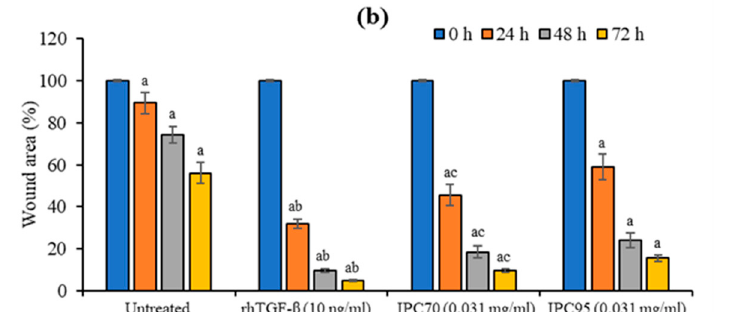
Figure 4. In vitro wound healing of CCD-986sk cells treated with IPC70 and IPC95 extracts. ( a ) Scratch wounds were observed using an inverted light microscopic (magnification × 100). ( b ) The percentage of cell-free or wound area was measured using the Image J program. The data are means ± SD from three independent experiments. The superscript letters ( a,b,c ) indicate a significant difference at p < 0.05; ( a ) treated cells at 24, 48, and 72 h were compared with treated cells at 0 h; ( b ) rhTGF- β -treated cells were compared with IPC-treated cells; ( c ) IPC70-treated cells were compared with IPC95-treated cells.